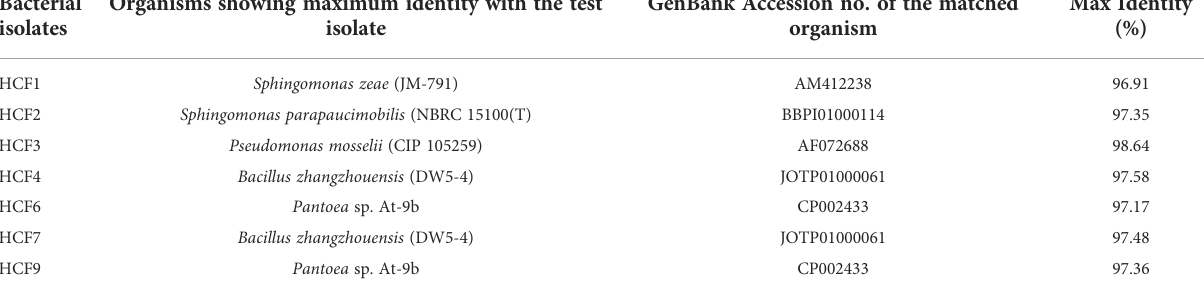
TABLE 1 Molecular identi fi cation of bacterial endophytes based on 16S rRNA gene sequencing. Bacterial isolates